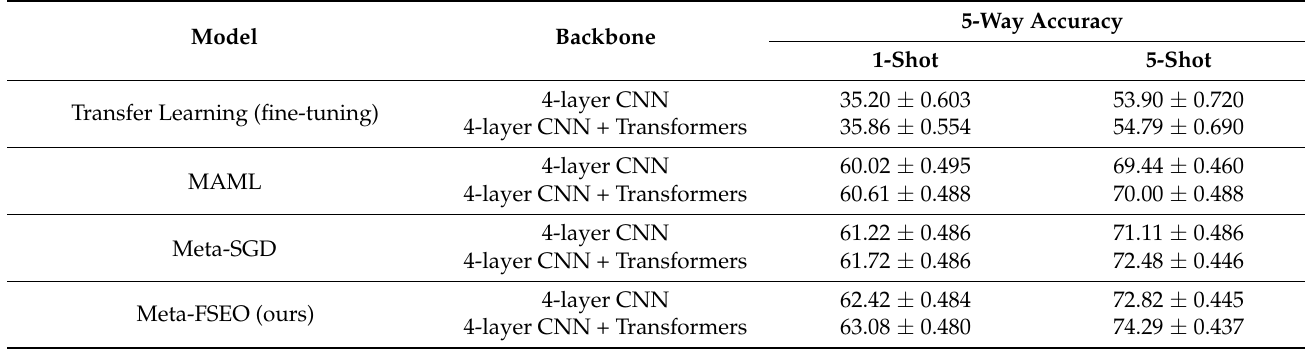
Table 2. The classification accuracy of different models on the SEN12MS dataset. The accuracy of Meta-FESO achieves the highest accuracy in one-shot and five-shot scenarios, surpassing the fine-tuning model, and two meta-learning models, i.e., MAML and Meta-SGD. The inclusion of the transformers module further improves performance for all